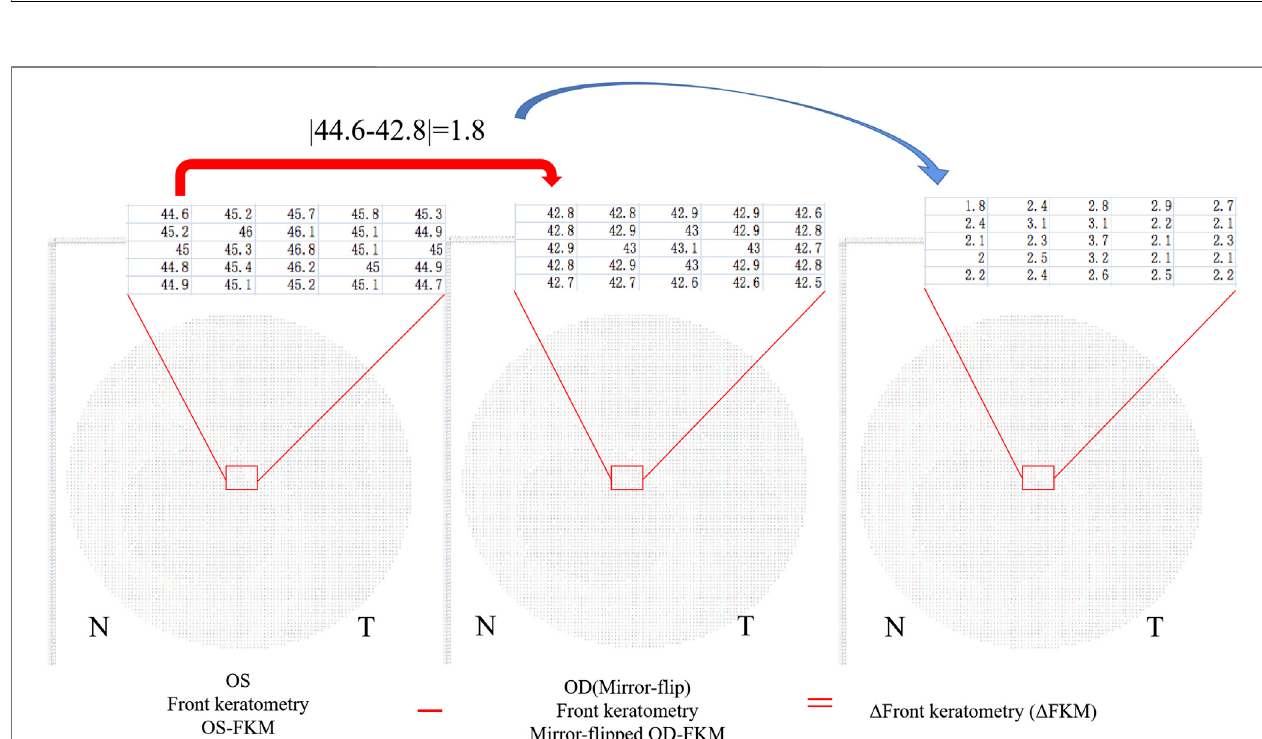
FIGURE 3 | Bilateral differential FKM ( Δ FKM) obtained by calculating the absolute value of the OS-FKM minus the mirror- fl ipped OD-FKM.